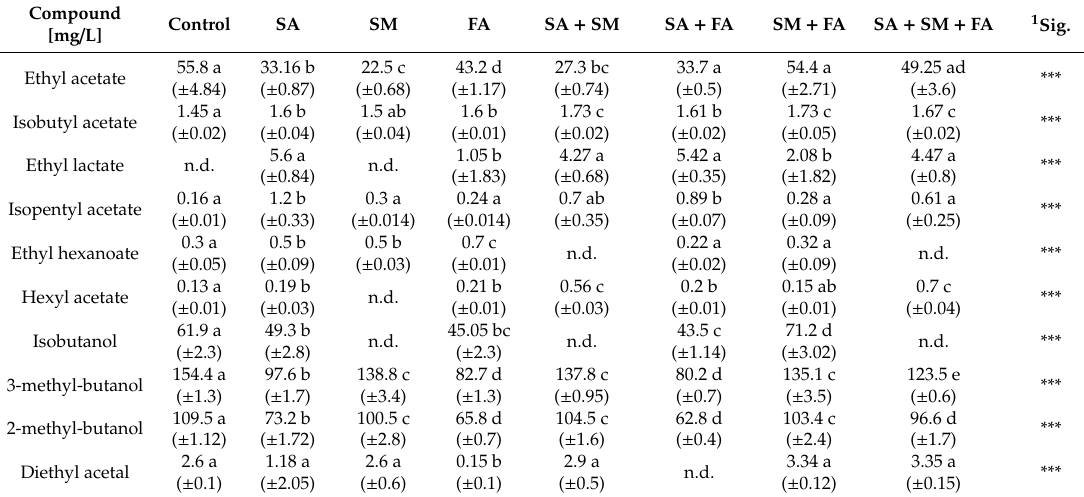
Table 10. Volatile compounds in ciders fermented by wine yeast (W), with the following additions: SA—ammonium sulfate, SM—magnesium sulfate, FA—ammonium